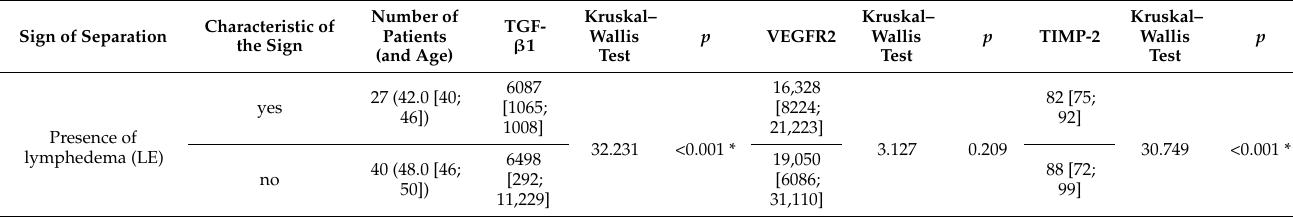
Table 5. Serum biomarker levels in the study subgroups,